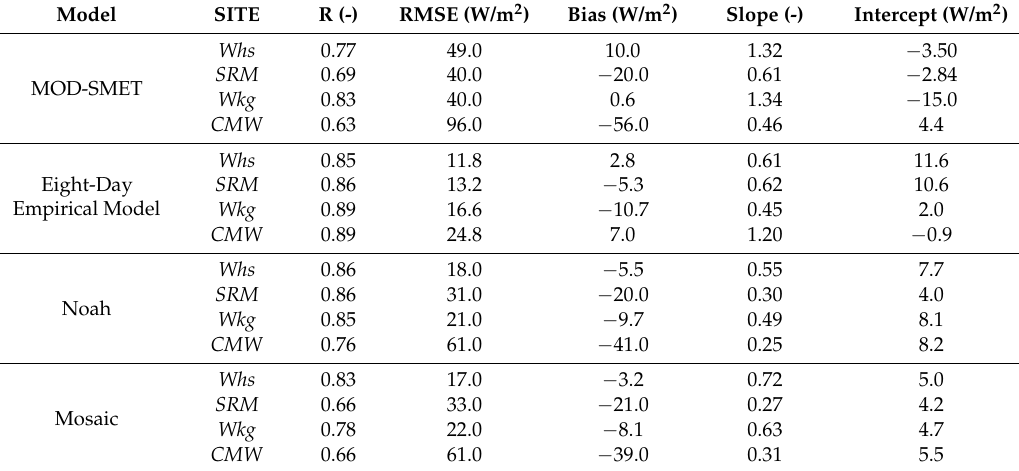
Table 3. Correlation coefficient (R), root mean square error (RMSE) (W/m 2 ), bias (W/m 2 ), slope (-) and intercept (W/m 2 ) between observed ground-based ET estimates and MODIS ET, the eight-day empirical model, Noah, and Mosaic models. For perfect agreement, slope = 1, intercept =